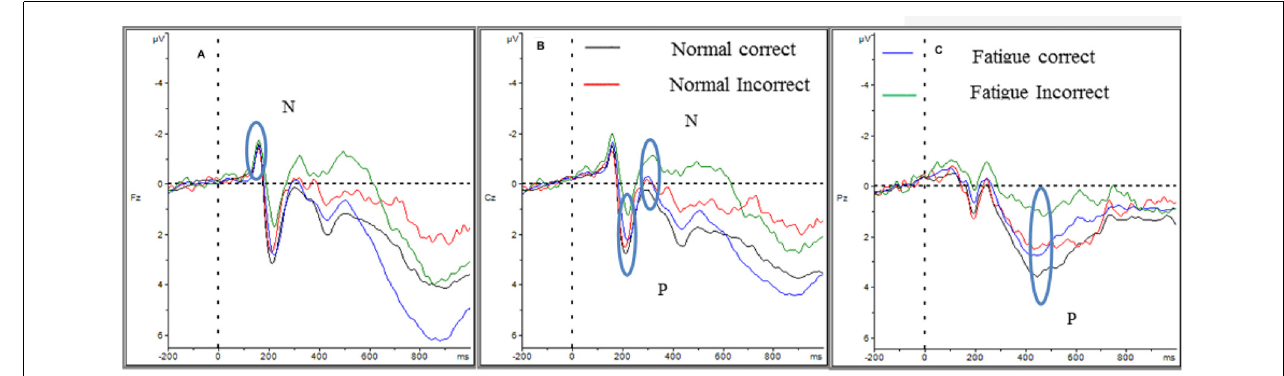
FIGURE 4 | ERPs of correct and error response at normal and fatigue. Panels (A–C) show the N1, P2, N2, and P3of the two trials in two-state. Panel (A) shows the four event-related potentials (ERPs) in Fz; panel (B) shows the four ERPs in Cz; and panel (C) shows the four RRPs in Pz. The N1 amplitude showed no difference. The P2 and P3 amplitudes diminished in fatigue state and error trials as well, while the N2 amplitude was larger.